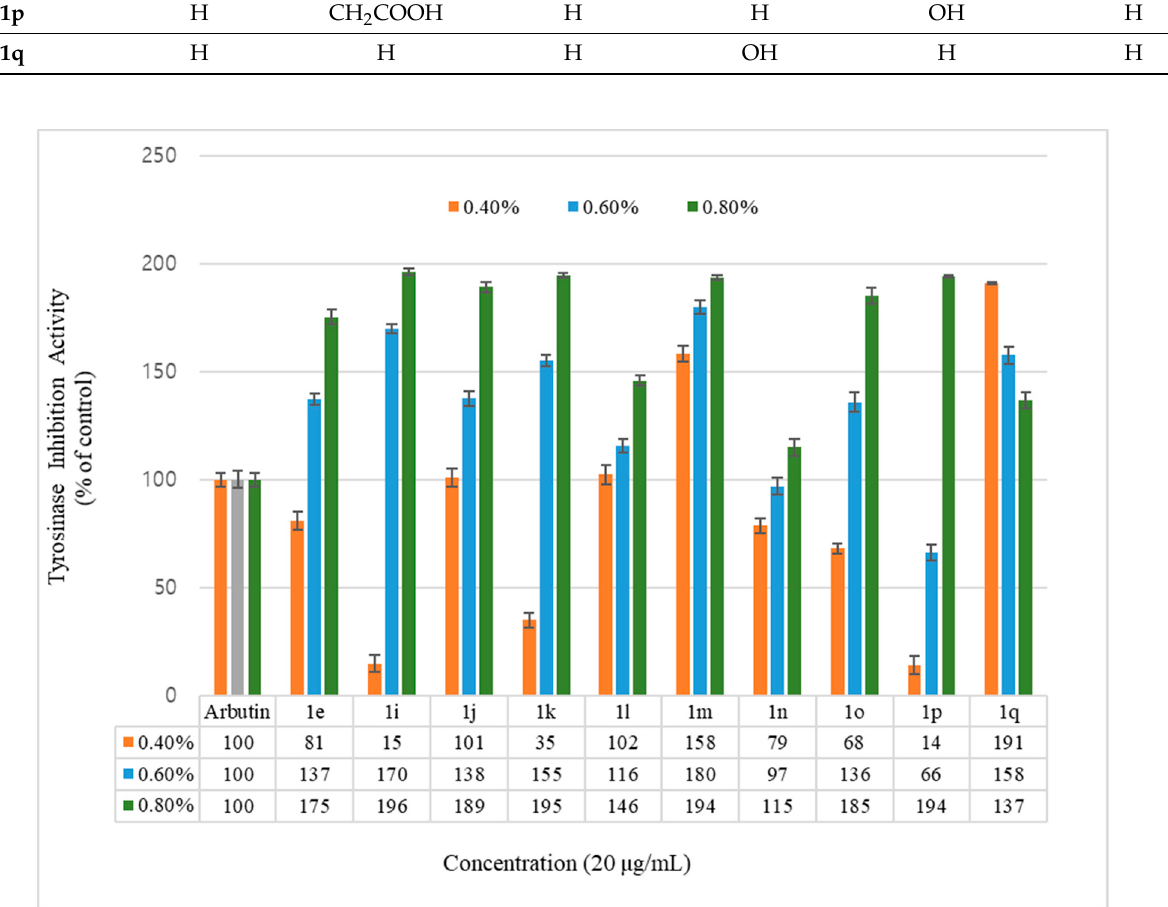
Figure 2. Mushroom tyrosinase activity effects of hydroxycoumarin derivatives and reference. Results are expressed as means ± SEMs.